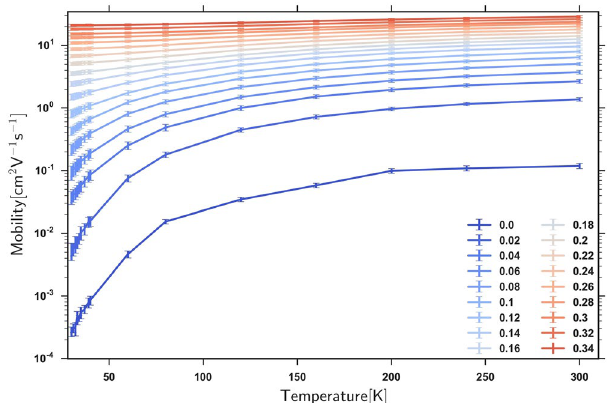
Figure 2. The temperature dependence of the electron mobility for a range of ( OE / σ ) sweeping from 0 to